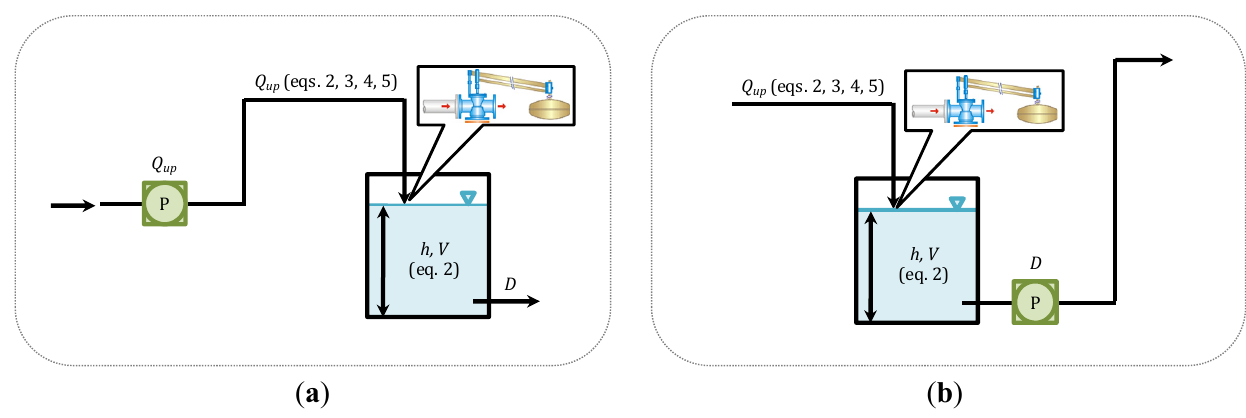
Figure 2. A schematic of the modelled pump-private tank system: ( a ) rooftop tank and ( b ) underground tank.